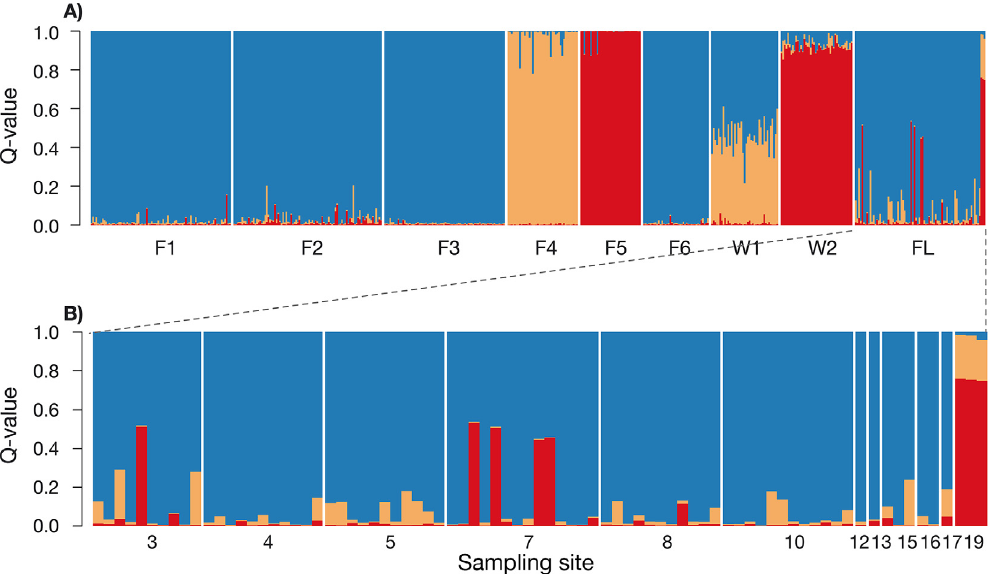
Fig. 5. Genetic structure of reference collections and free-living Atlantic salmon using STRUCTURE K = 3. (A) Q-values among reference collections (F1, F2, and F3: farmed Norway; F4: farmed Ireland; F5: farmed Canada; F6: farmed Scotland; W1: wild Scotland; W2: wild Canada) and free-living Atlantic salmon (FL); (B) Q-values from each sampling site of free-living Atlantic salmon. Red and blue colors represent North American and European clusters, respectively. Yellow represents an Ireland cluster, which shows a common ancestry with the wild Scotland